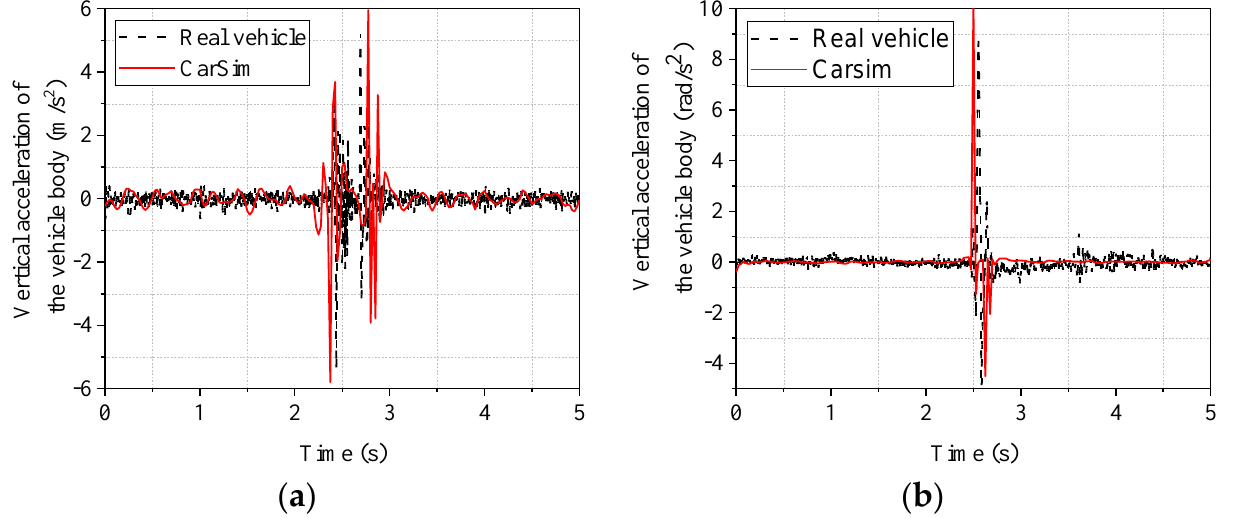
Figure 8. Response of the body when passing over a triangular speed bump. ( a ) vertical acceleration